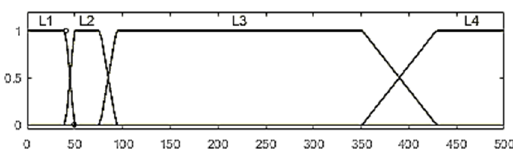
Figure 11. Input membership functions for C 2 H 2 . Figure 12. Input membership functions for C 2 H 4 . Figure 12. Input membership functions for C 2 H 4